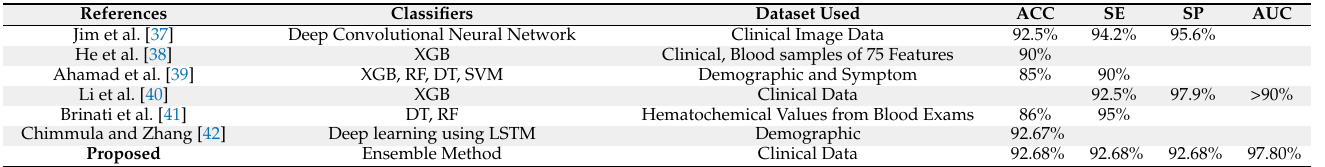
Table 4. Comparison with related works.